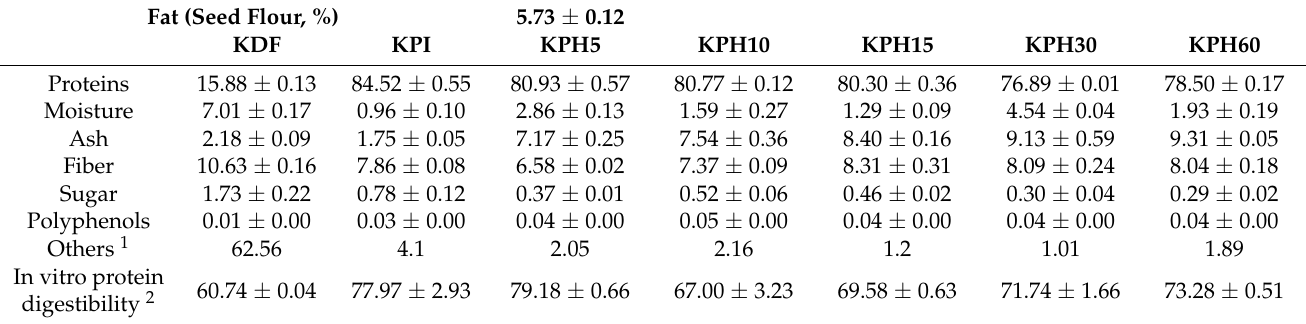
Table 1. Chemical composition of kiwicha protein